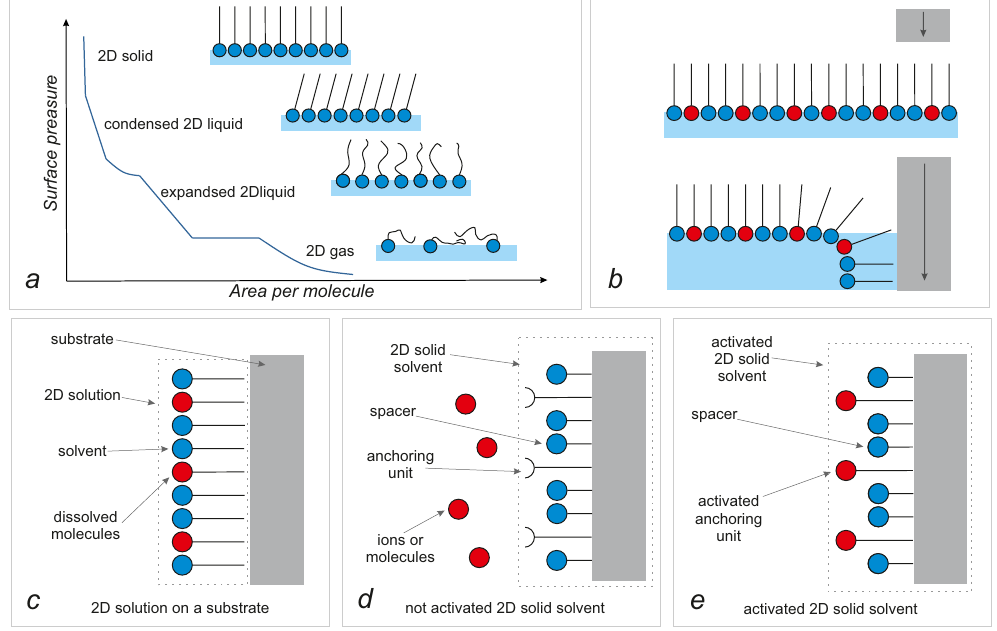
Figure 2. The scheme illustrating the main principles of a 2D solid solvent concept ( c – e ) in comparison to Langmuir monolayer ( a ) and Langmuir-Blodgett films ( b